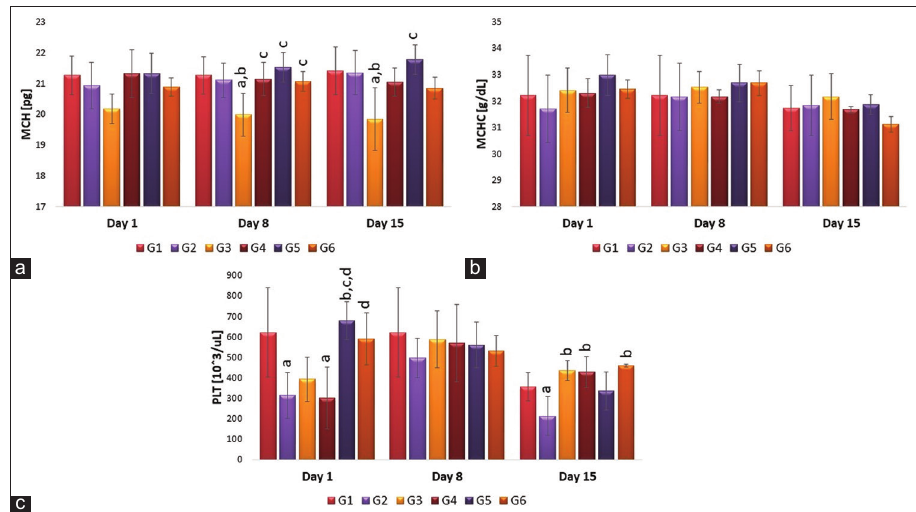
Figure-7: (a-c) Effects of single and repeated intravenous injection of 300 μ g/kg body weight 50 nm either gold nanosphere or gold nanorods in male rabbits on mean corpuscular hemoglobin, mean corpuscular hemoglobin concentration, and PLT on days 1, 8, and 15 post-treatment. Means carrying superscripts are significantly different at p<0.05 based on Tukey’s honestly significant difference. a=Significantly different versus G1, b=Significantly different versus G2, c=Significantly different versus G3, d=Significantly different versus G4, and e=Significantly different versus